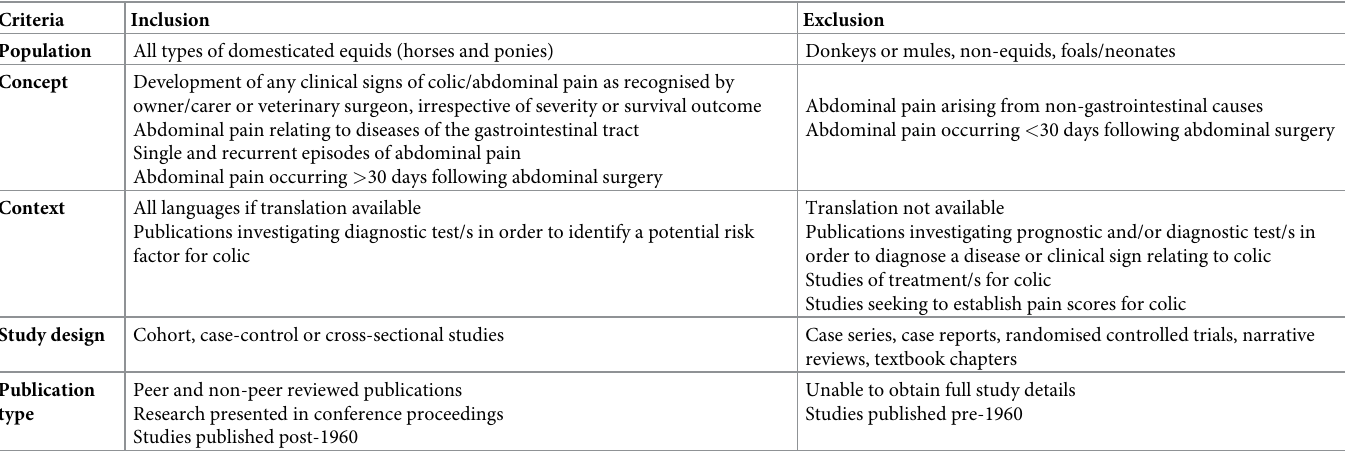
Table 1. Inclusion and exclusion criteria for a scoping review of risk factors associated with the development of abdominal pain (colic) in horses and ponies.